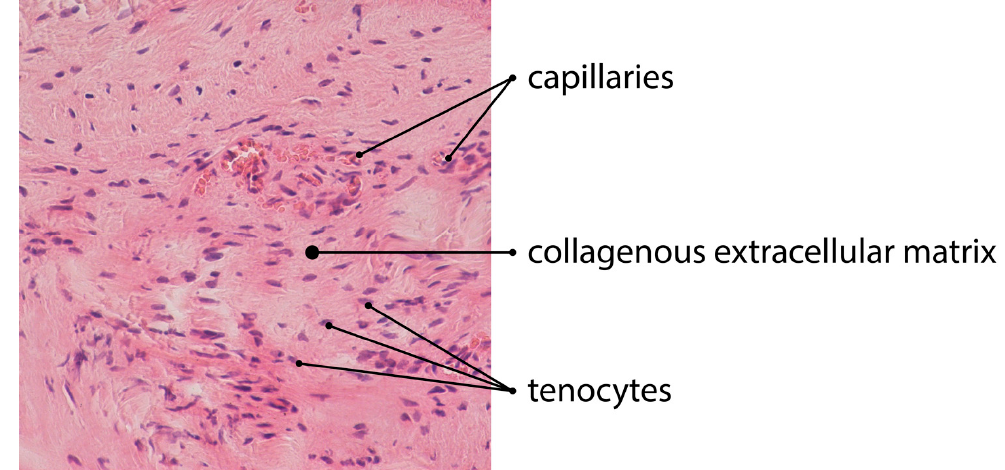
Figure 1. H&E staining of tendinous tissue showing angiogenesis (magnification of the objective: 20 × ). The process is specifically regulated by the local microenvironment components, such as mediators and ECM [62]. However, the exact levels of these mediators are still unknown. The ECM regulates the topology and elongation of vessels, using the proteases to pave the way for new capillaries [70]. Some authors observed that angiogenesis is sig- nificantly reduced in the areas of the tendinous tissue, with the increased production and aggregation of non-collagenous ECM [17,71] (Figures 2 and 3).